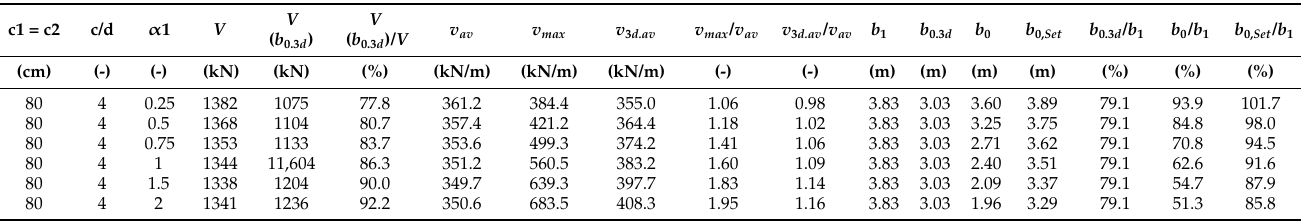
Table A1. Analysis of the shear force distribution in the control perimeter 0.5 d with 80 cm shear cap